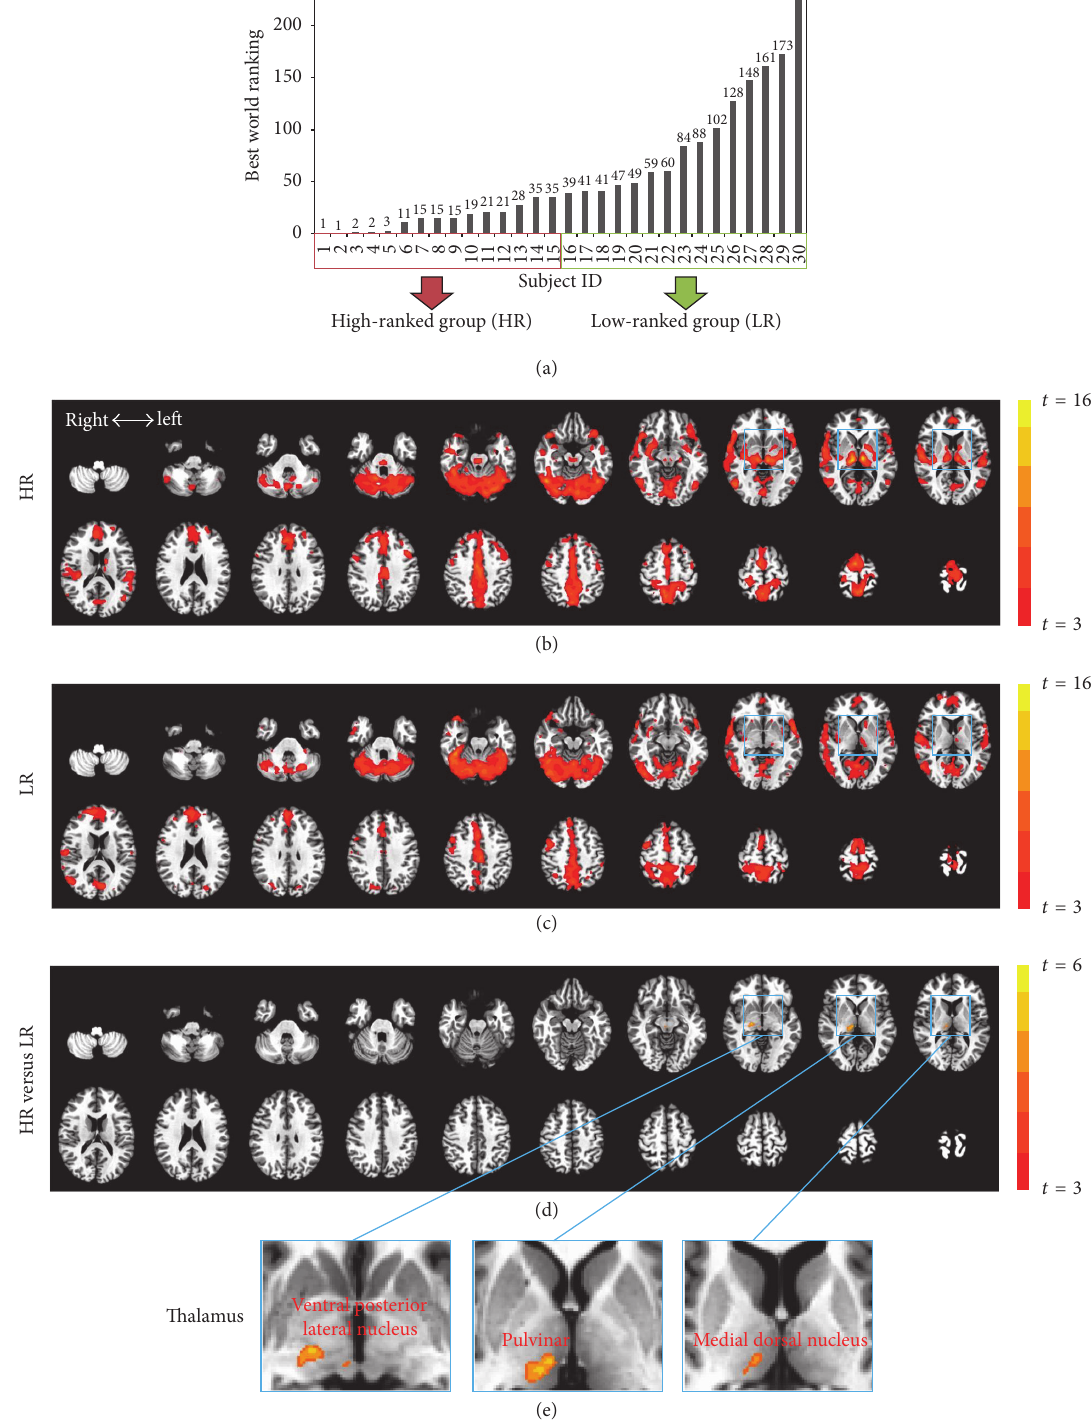
Figure 1: Whole-brain functional connectivity (FC). (a) High-ranked (HR; 𝑛 = 15 , rank: 1–35) and low-ranked (LR; 𝑛 = 15 , rank: 39–228) swimmers were divided by a median split in world rankings. (b) The number of functional connections (positive correlations) between an individual voxel and all remaining voxels in the brain was computed by degree of centrality analysis. Whole-brain FC map for HR swimmers is shown by a one-sample 𝑡 -test (against zero). (c) Whole-brain FC map for LR swimmers. (d) HR swimmers show stronger net connections between the right thalamus and the whole brain when compared to those in the LR by a whole-brain two-sample 𝑡 -test. (e) Magnified views of the thalamus show significant group differences in the ventral posterior lateral nucleus, the pulvinar, and the medial dorsal nucleus. All resulting 𝑡 -maps were thresholded at a corrected 𝑝 value of <